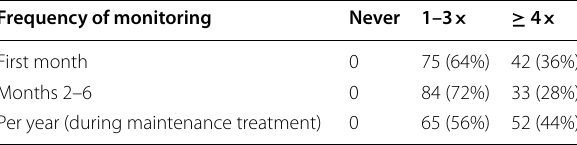
Table 2 Frequency of monitoring lithium serum